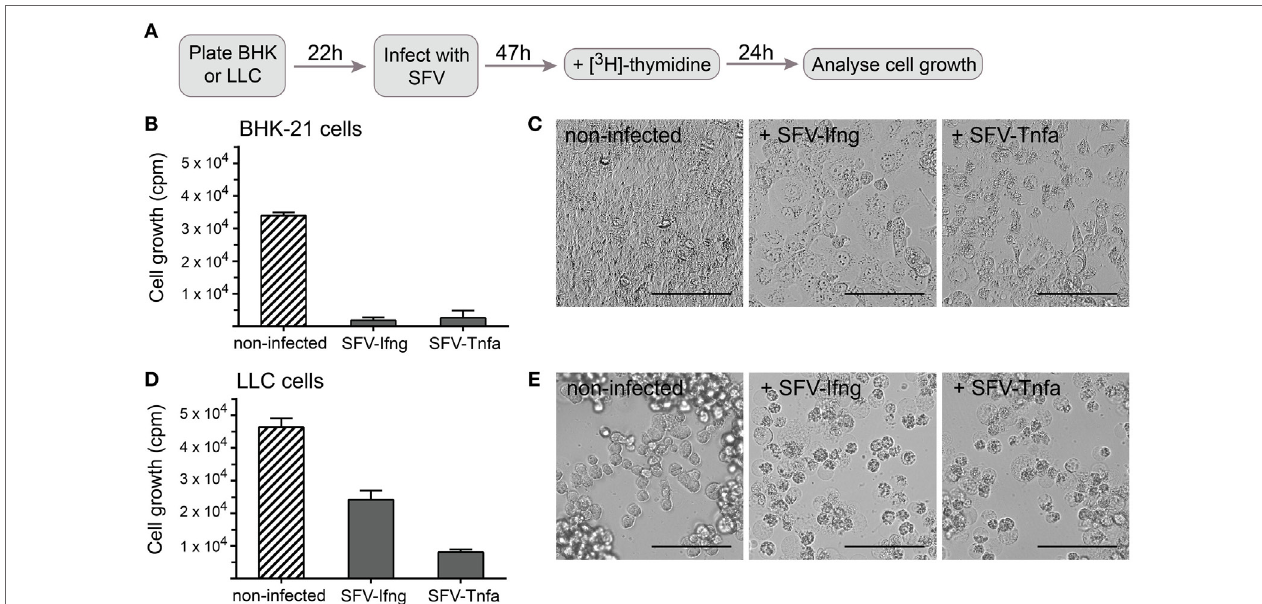
FigUre 5 | Cancer cell growth is inhibited by infection with Semliki Forest virus (SFV) particles. (a) Schematic overview of the experiment. Baby hamster kidney (BHK-21) or Lewis lung carcinoma (LLC) cells were plated and incubated for 22 h before they were infected with SFV-Ifng or SFV-Tnfa particles at MOI = 15. The cells were incubated for 47 h after infection, and [ 3 H]-thymidine was then added to detect proliferating cells. After 24 h, the cells were harvested, and cell growth was determined by measuring the incorporated [ 3 H]-thymidine as counts per minute (cpm, depicted on the y -axis). (B) As expected, infecting BHK-21 cells with SFV resulted in substantial growth inhibition. (c) BHK-21 cells underwent cell death 47 h post-infection as observed using bright-field microscopy (scale bars, 50 µm). (D) LLC cell growth was inhibited by infection with different SFV particles. (e) LLC cells underwent cell death 47 h post-infection as observed using bright-field microscopy (scale bars, 50 µm). Two experiments were performed in triplicates with SE not exceeding 10% between independent experiments. The bars represent the mean values of triplicates ± SEM from one representative